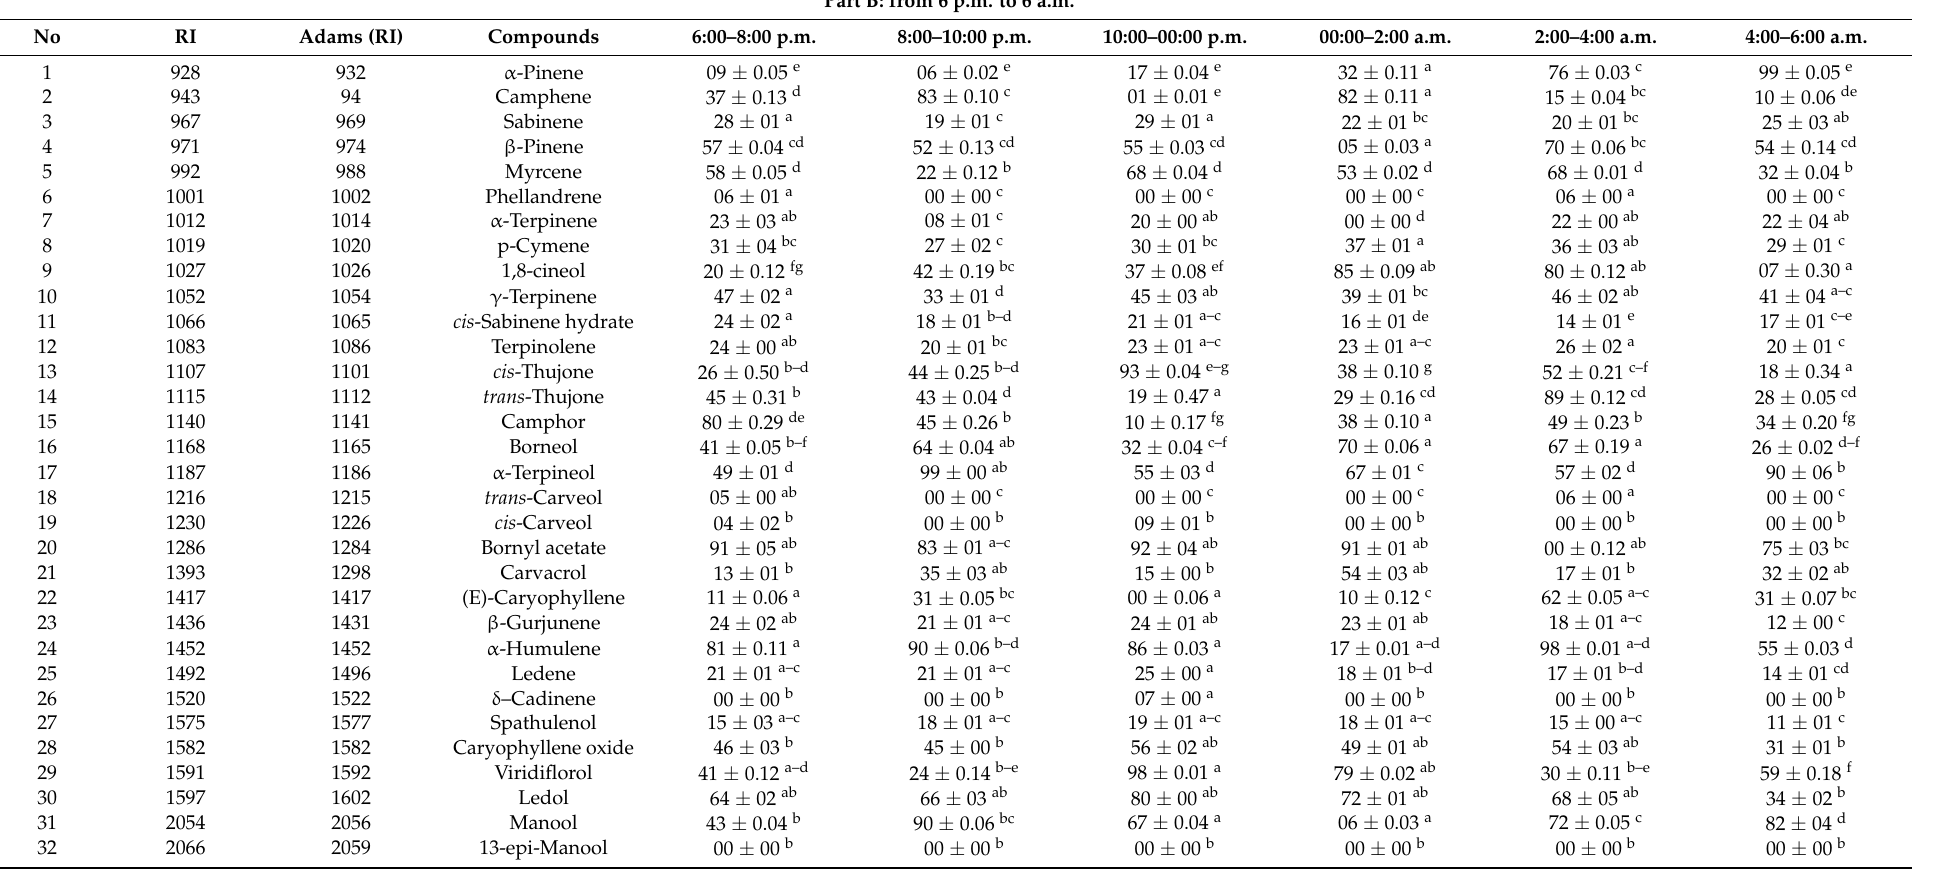
Part B: from 6 p.m. to 6